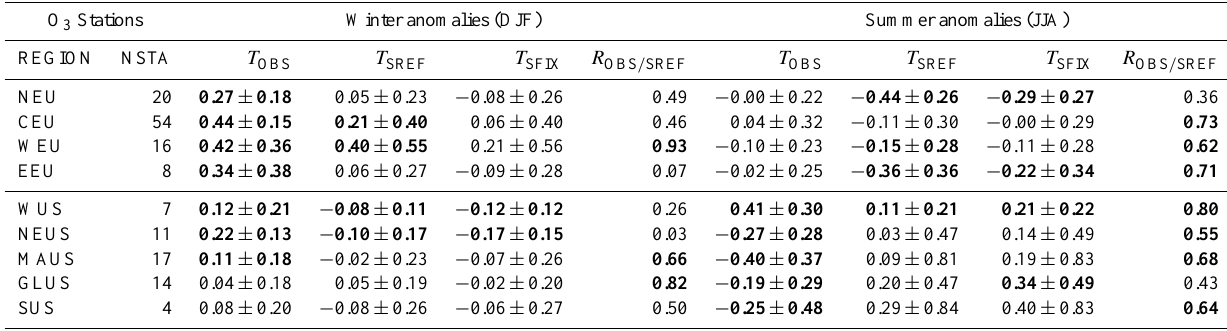
Table B1. Observed and simulated trends of surface O 3 seasonal anomalies for European (EU) and North American (NA) stations, grouped as in Fig. 1 (Northern Europe (NEU); Central Europe (CEU); Western Europe (WEU); Eastern Europe (EEU); Western US (WUS): North- Eastern US (NEUS); Mid-Atlantic US (MAUS); Great lakes US (GLUS); Southern US (SUS)). The number of stations (NSTA) for each regions is listed in the second column. The seasonal trends are listed separately for winter (DJF) and summer (JJA). Seasonal trends (ppbvyr − 1 ) are calculated for observations ( T OBS ), SREF and SFIX simulations ( T SREF and T SFIX ) as linear fitting of the median surface O 3 anomalies of each group of stations (the 95% confidence interval is also shown for each calculated trend). The statistically significant trends (p-value < 0.05) are highlighted in bold. The correlation coefficient between median observed and simulated (SREF) anomalies are listed ( R OBS / SREF ). The statistically significant correlation coefficients (p-value < 0.05) are highlighted in bold. O 3 Stations Winter anomalies (DJF) Summer anomalies (JJA) REGION NSTA T OBS T SREF T SFIX R OBS / SREF T OBS T SREF T SFIX R OBS / SREF